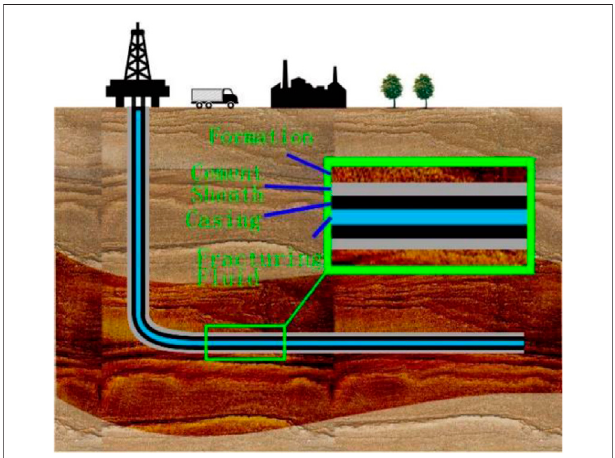
FIGURE 1 | Diagram of a well in energy exploitation and storage.